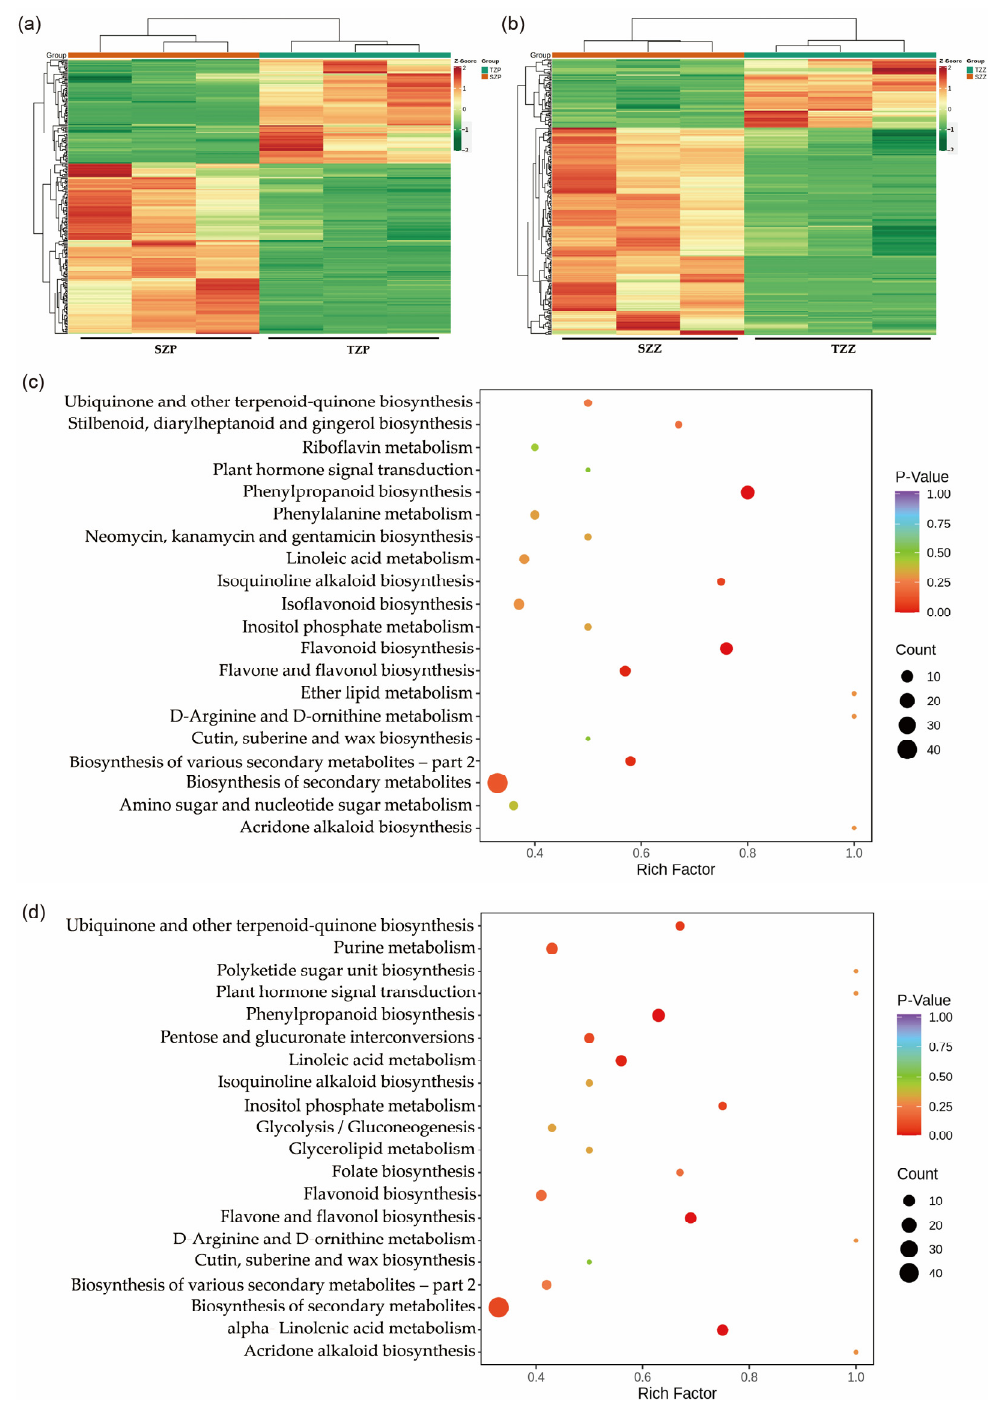
Figure 3. Differentially accumulated metabolites among seed coats and cotyledons of S006 vs. TL. ( a ) A heat map of differential metabolites among SZP vs. TZP; ( b ) a heat map of differential metabolites among SZZ vs. TZZ; ( c ) KEGG-pathway-enrichment analysis of differential metabolites among SZP vs. TZP; ( d ) KEGG-pathway-enrichment analysis of differential metabolites among SZZ vs.